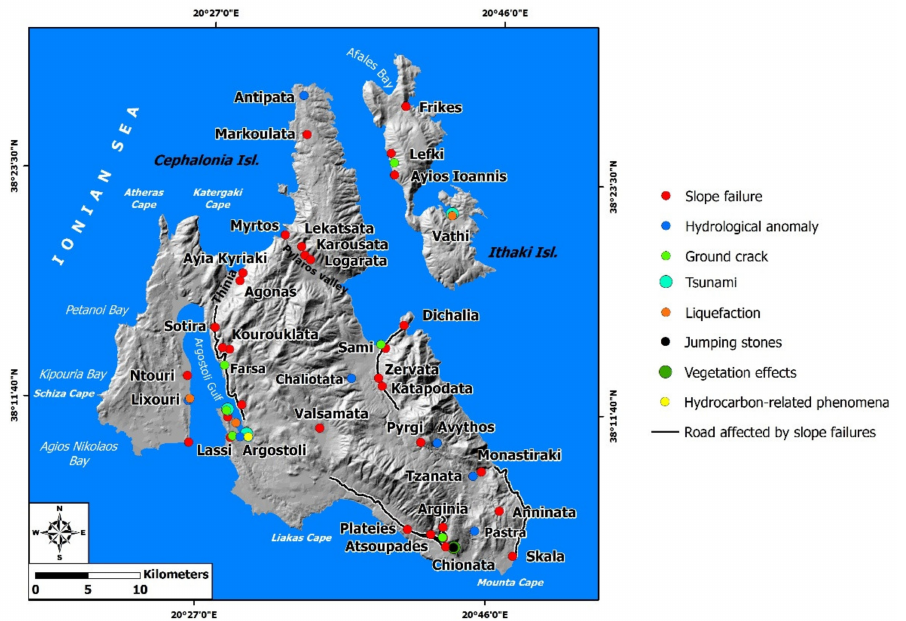
Figure 11. Secondary environmental effects induced by the 12 August 1953 Ionian Sea earthquake in Cephalonia